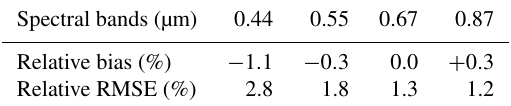
Table 1. Relative bias and root mean square error in percentage between FASTRE and the reference RTM in various spectral